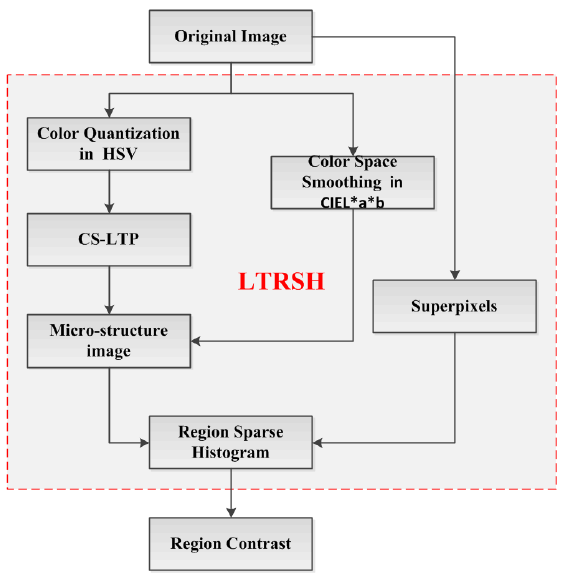
Figure 4. The scheme of region contrast computation based on